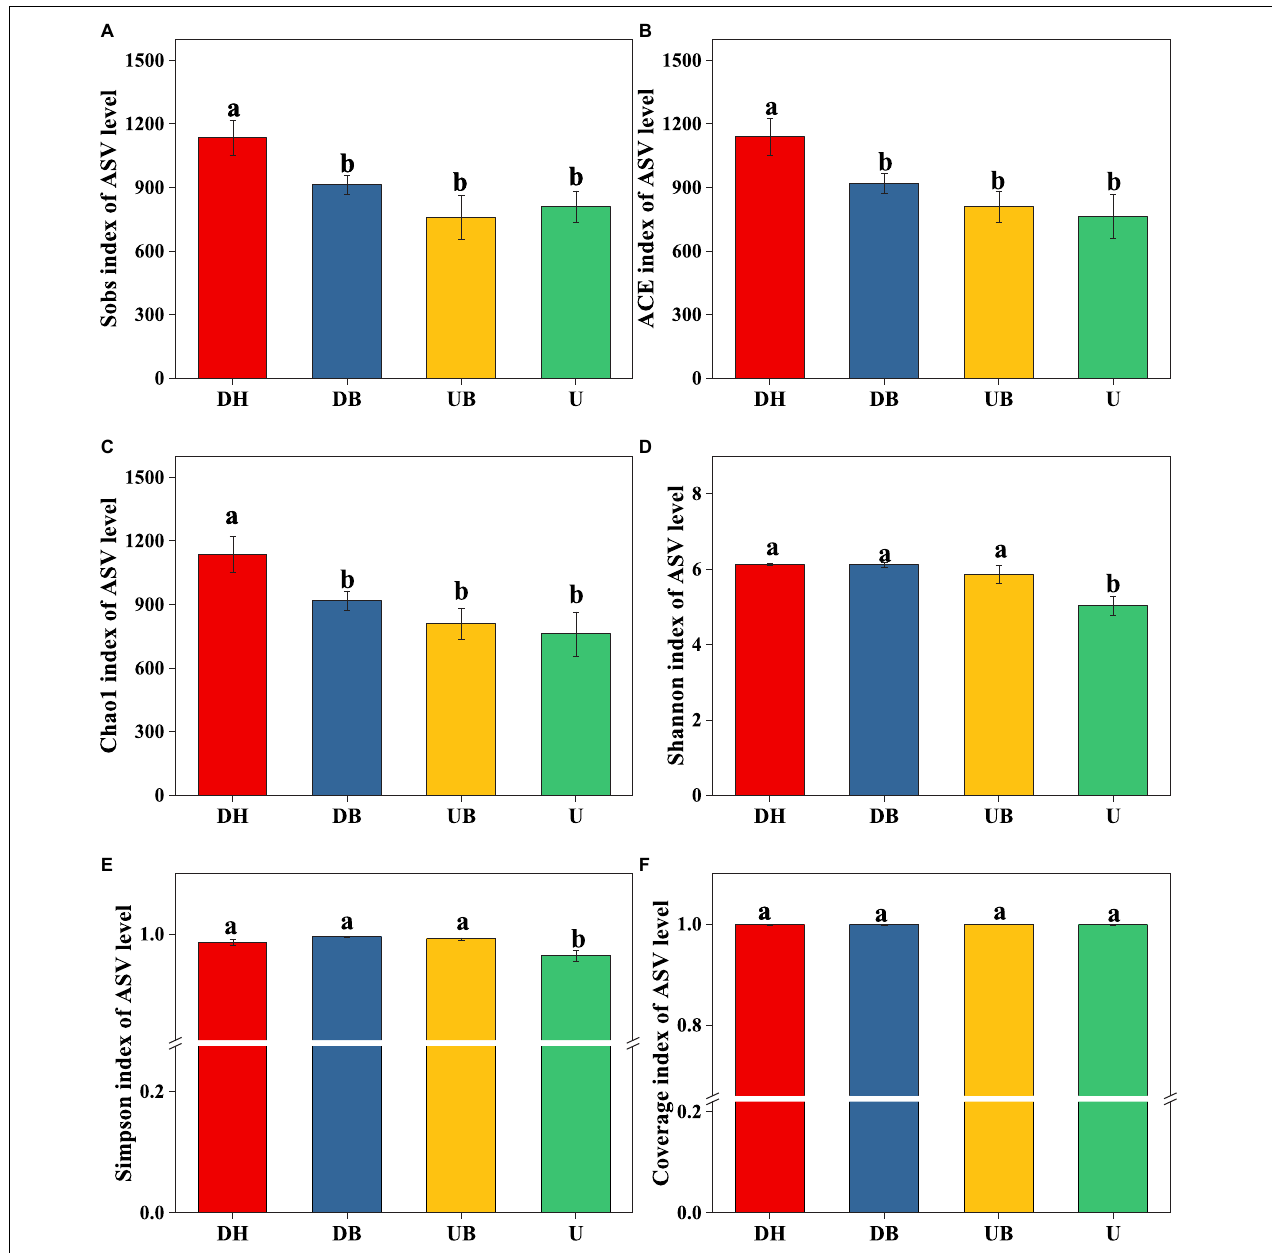
FIGURE 3 | Bacterial α -diversity at different disturbance levels of biocrusts ( n = 3). (A) Sobs index. (B) ACE index. (C) Chao1 index. (D) Shannon index. (E) Simpson index. (F) Coverage index. Significant differences ( P < 0.05) are marked by different